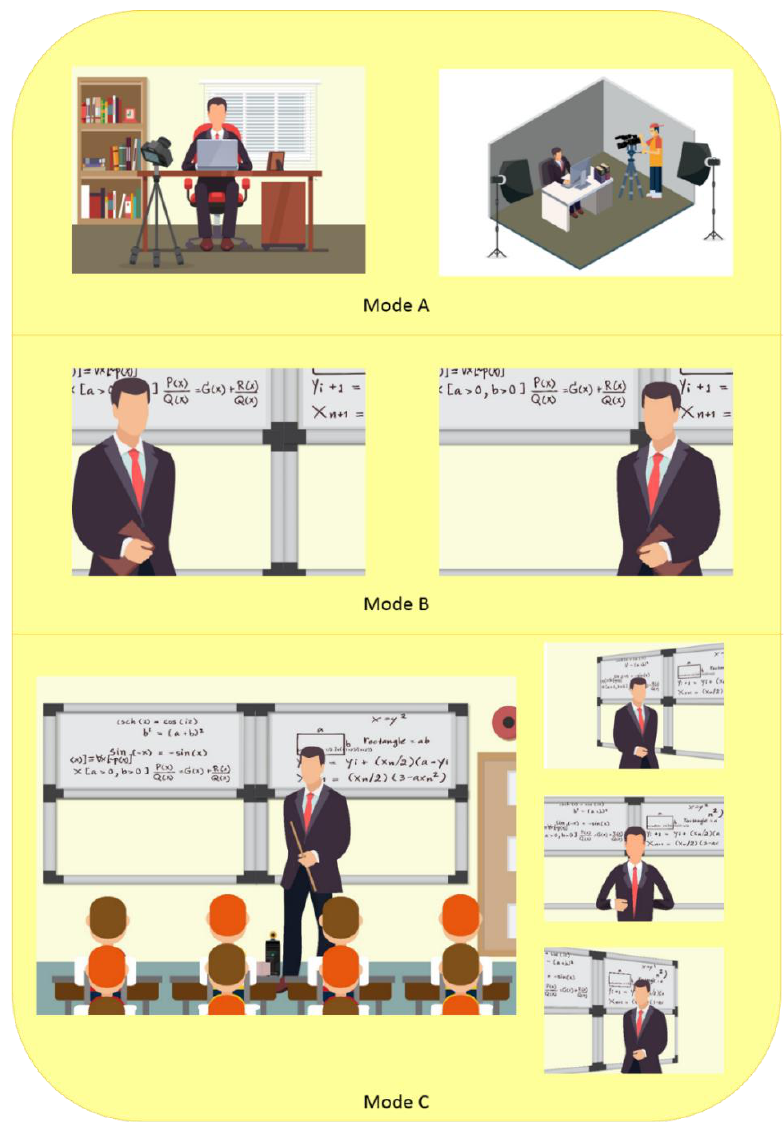
Figure 1. Three modes for recording online course videos. Mode A : Capturing in an office or a professional studio. Mode B : Capturing with a static camera in a classroom. Mode C : Automatic tracking and capturing in a classroom (the proposed system).